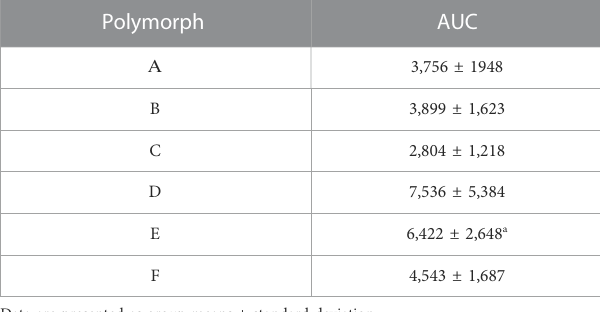
TABLE 8 AUC values for brain tissue samples calculated by the trapezoid method.